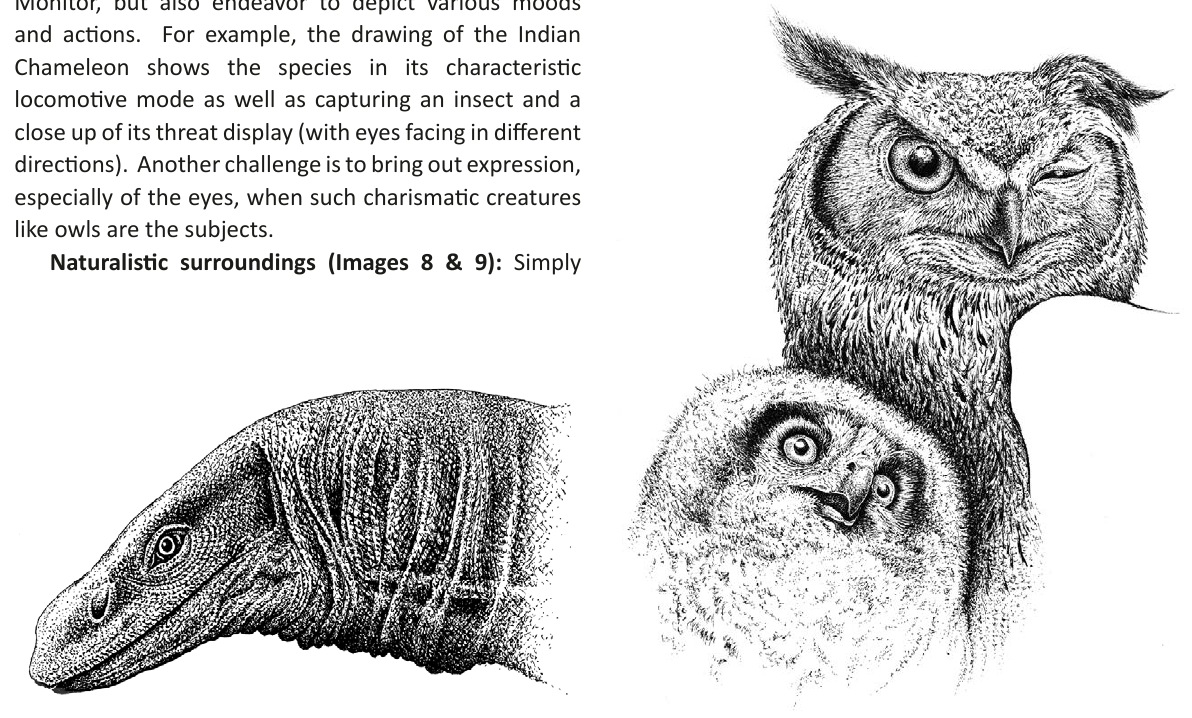
Image 7. Indian Eagle Owl Bubo bengalensis . Drawn using archival ink and drawing pen (Micron